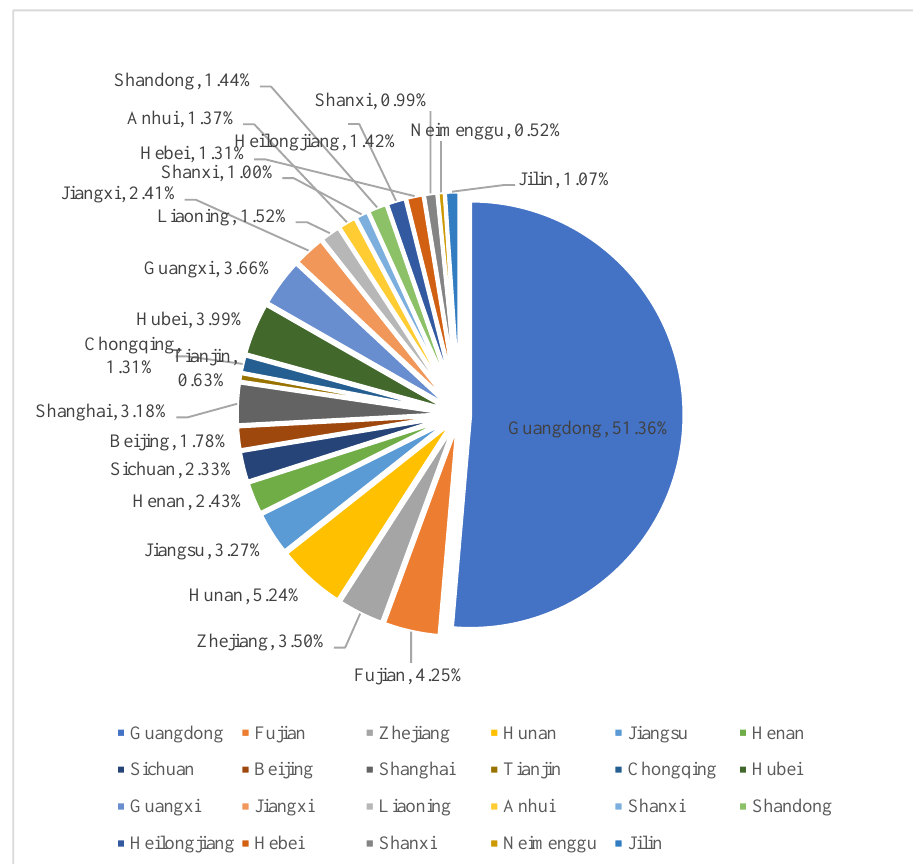
Figure 2. Statistics of cumulative inbound passengers based on visa issuance from 2017 to 2019.